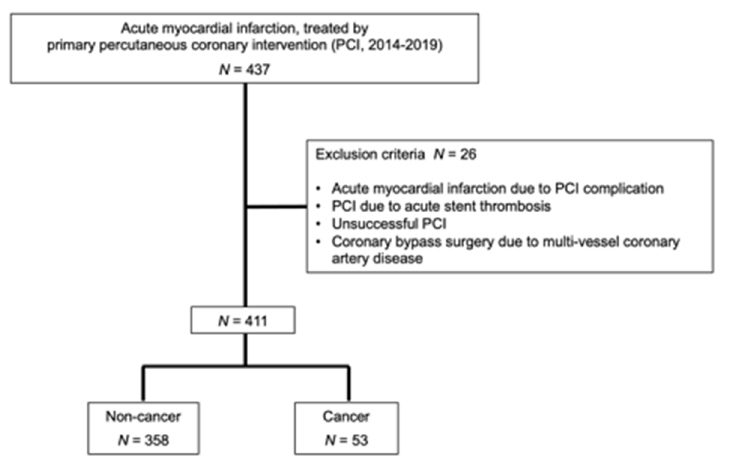
Figure 1. Enrollment of patients.